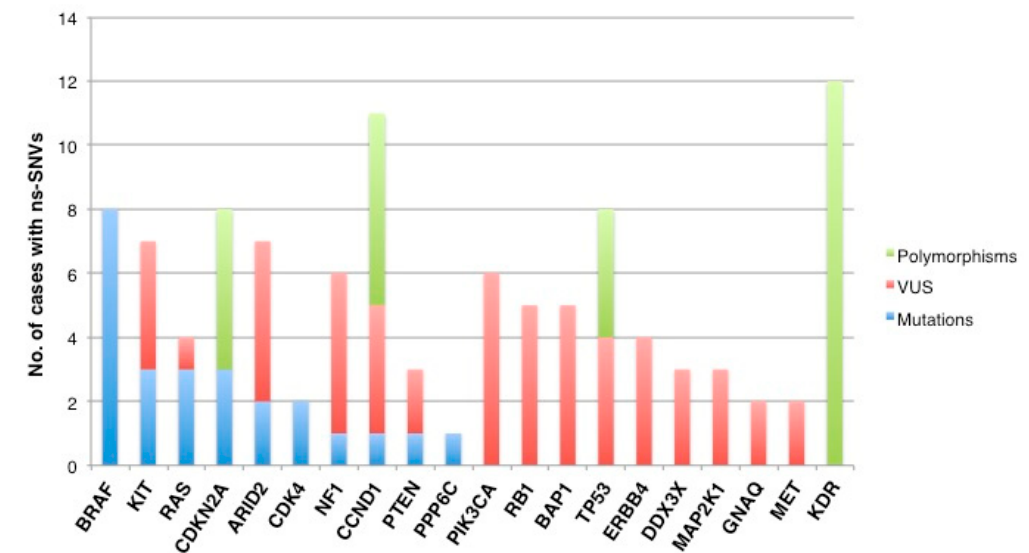
Figure 2. Type of non-synonymous sequence variants per gene. The graph summarises the number of pathogenic mutations (light blue bars), variants of unknown significance (red bars), and single-nucleotide polymorphisms (green bars) found in each individual gene analysed. ns-SNV, non-synonymous single nucleotide variants. VUS, variant of unknown significance. Mutations are intended as pathogenic variants.